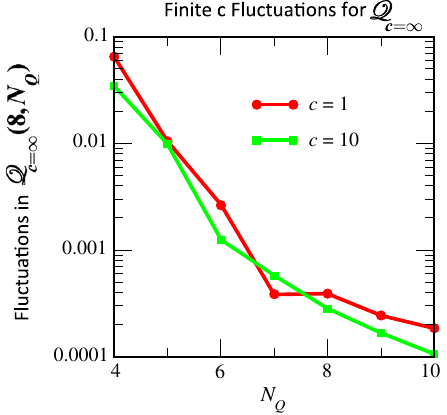
FIG. 6. We demonstrate that the effective charges constructed analytically at c ¼ ∞ , as described in detail in Appendix B, have suppressed temporal fluctuations for quenches with finite c ¼ 1 ; 10